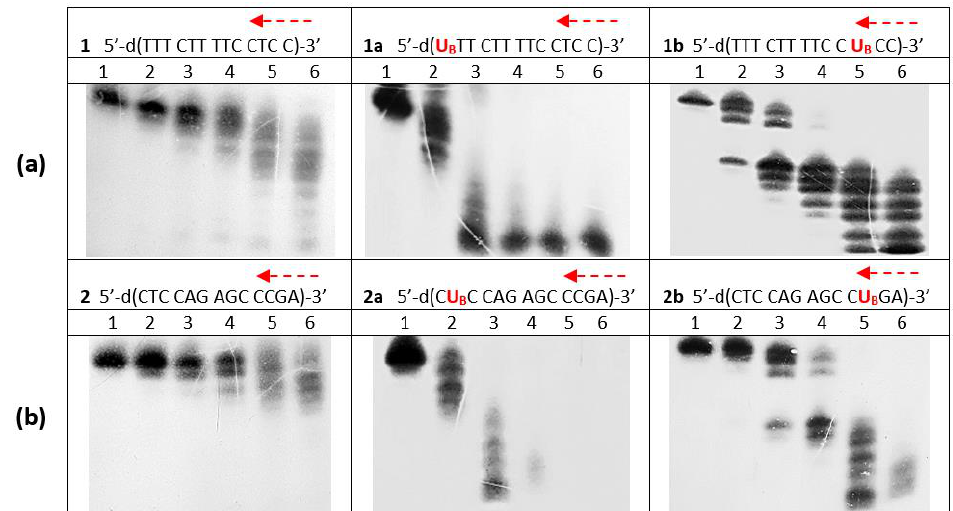
Figure 2. Autoradiograms of 20% denaturing PAGE, showing the cleavage kinetics of 5′- 32 P-labeled oligonucleotides 1 , 1a and 1b (panel a ) and 2 , 2a and 2b (panel b ) after treatment with svPDE over 0–90 min. Lanes 1, 2, 3, 4, 5 and 6 correspond to samples analyzed at 0, 5, 15, 30, 60 and 90 min. The experimental conditions are described in the Materials and Methods section.